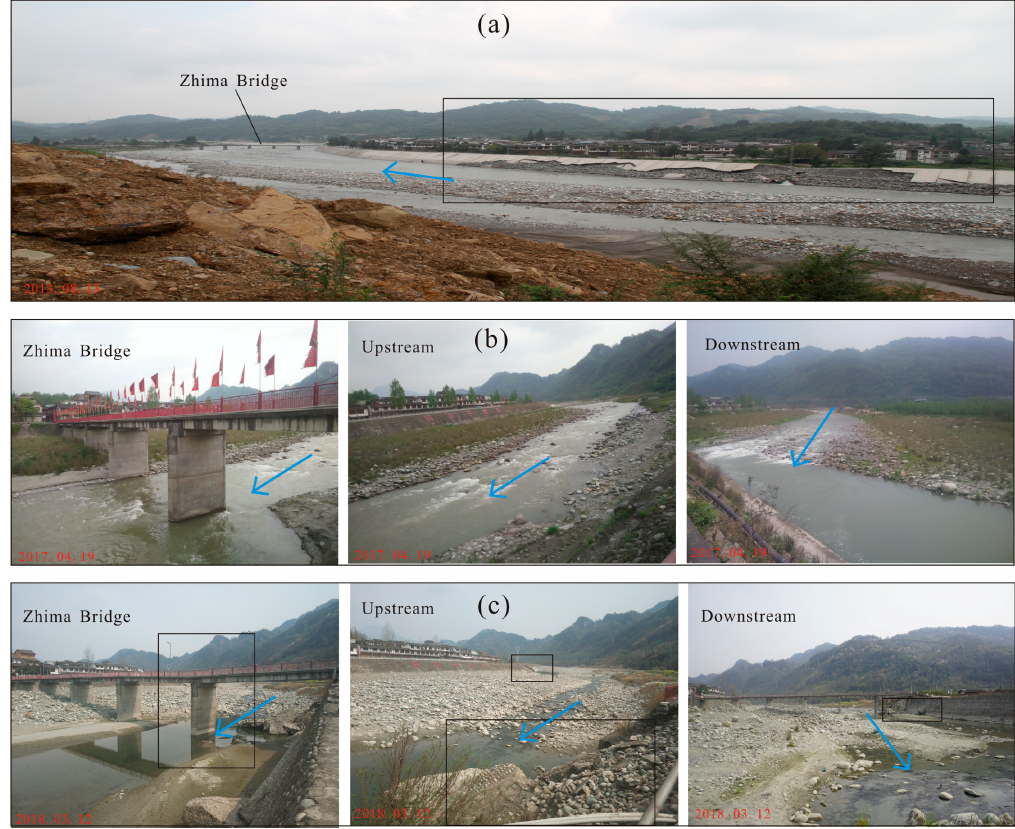
Figure 2. Pictures of the riverbed changes in the Zhima Bridge reach of the Jianjiang River: ( a ) riverbed and bank scour after the “9 July” flood in 2013; ( b ) harmonious scenes around Zhima Bridge several years after the completion of the river restoration project for the “9 July” flood in 2013, but before the flood season in 2017; and ( c ) bad conditions around Zhima Bridge after the flood disaster in the summer of 2017, where the bridge was destroyed because of a pier sinking due to scour, and the embankments were destroyed locally by the rush of the flood. In addition, the riverbeds and the flood plains were severely